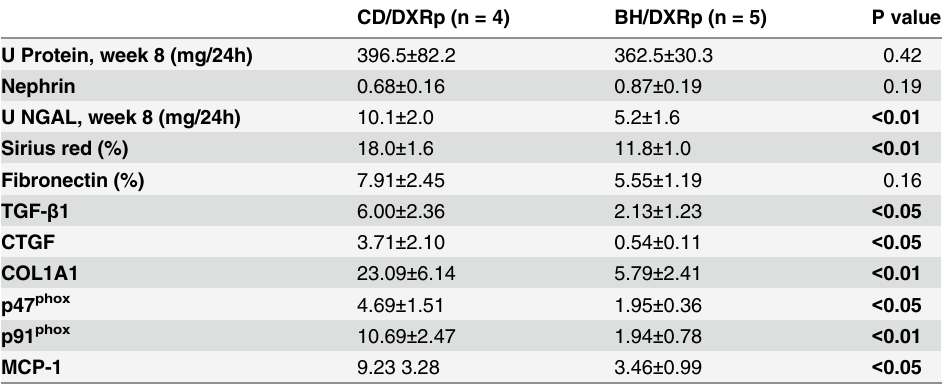
Table 3. Comparison of doxorubicin-injected (DXR) Rowett, black hooded (BH) and Charles Dawley (CD) rats with similar proteinuria (BH/DXRp and CD/DXRp